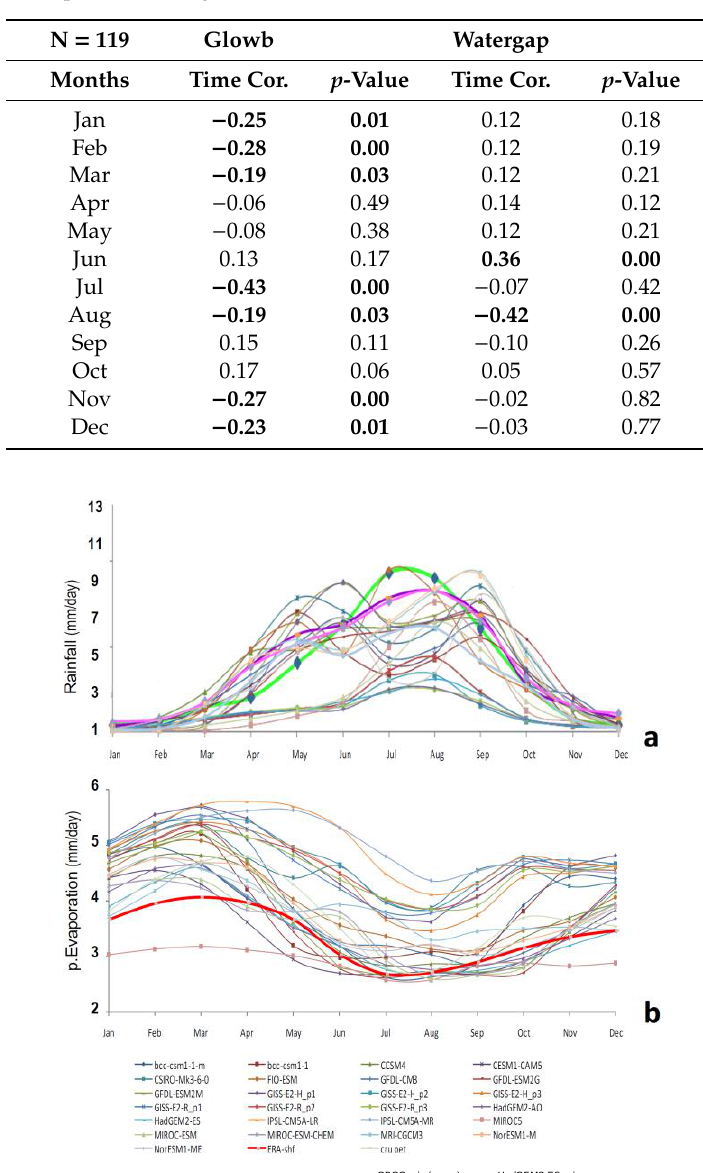
Figure A1. Mean annual cycle of NW Ethiopian highlands area-averaged ( a ) P and ( b ) E derived from SHF; comparing all 25 CMIP5 simulations with observation/reanalysis reference (bold green upper, bold red lower) 1981 – 2010. HadGEM2-ES rainfall (upper) is bold pink.